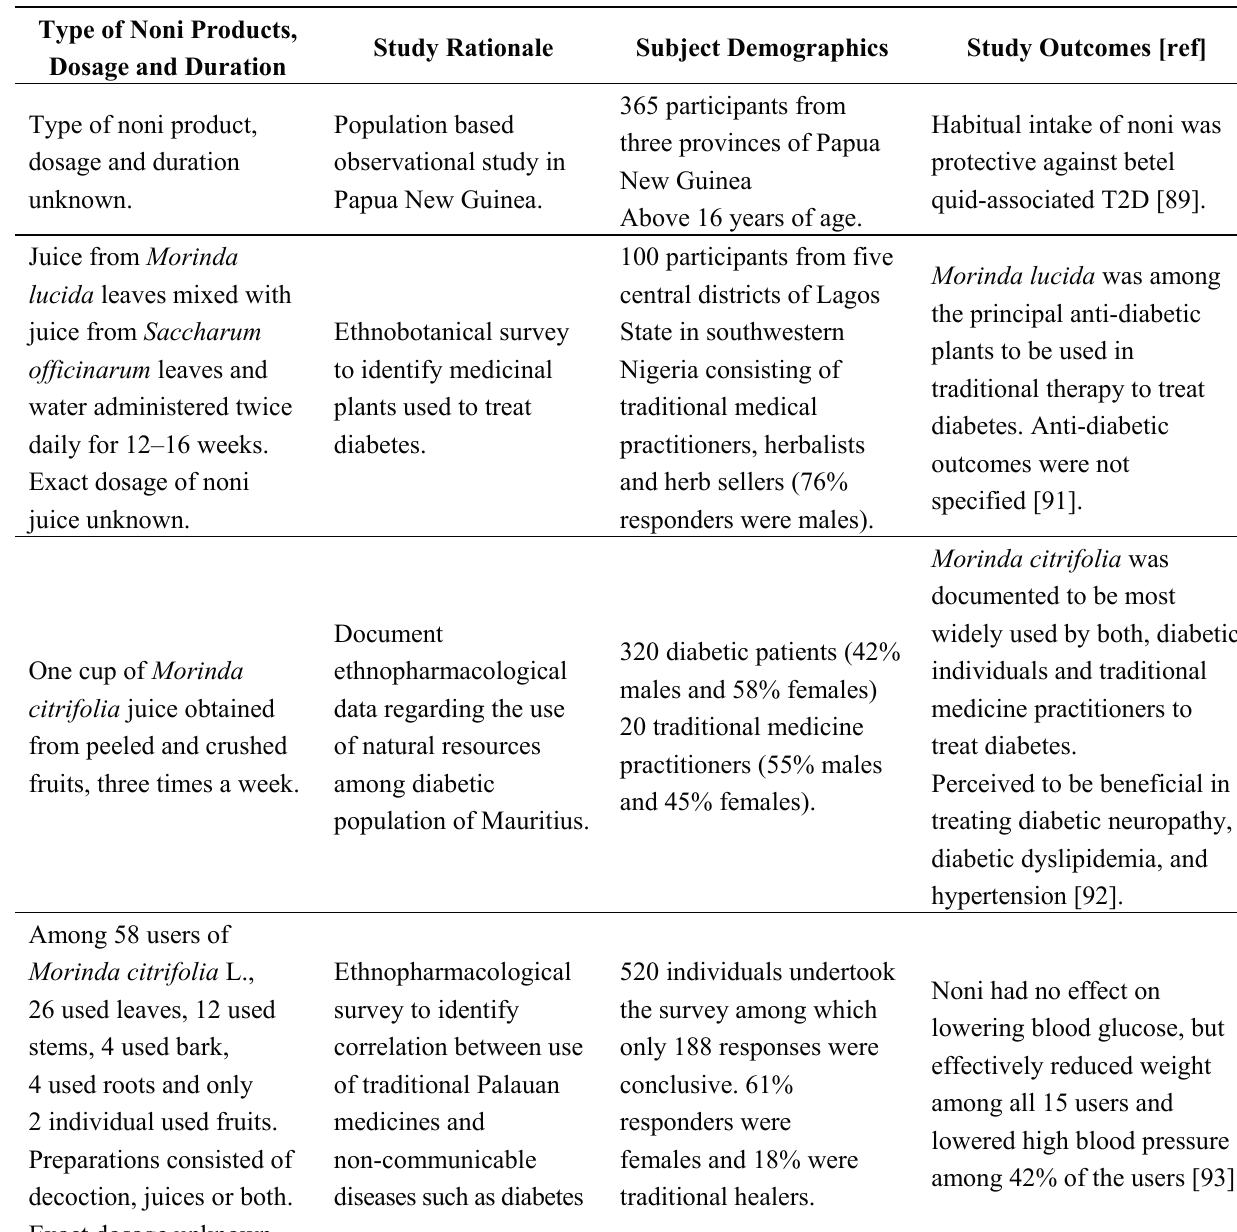
Table 3. Human studies in support of anti-diabetic properties of